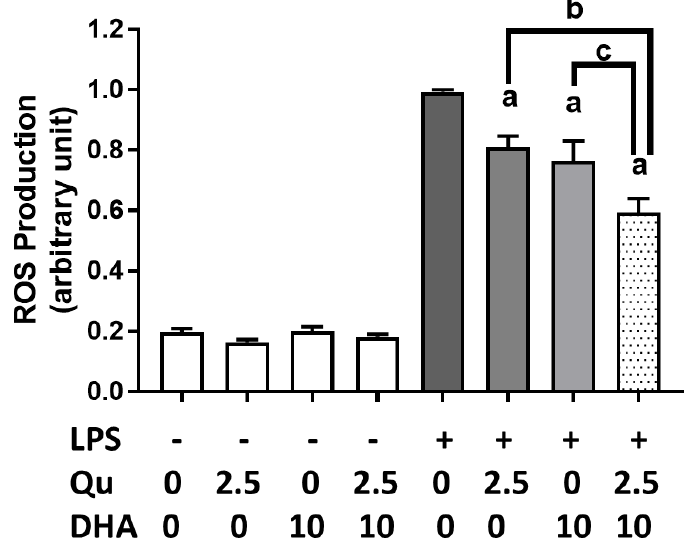
Figure 2. Effects of DHA and/or quercetin on LPS-induced reactive oxygen species (ROS) production in microglial cells. ROS was detected using CM-H 2 DCFDA (DCF), as described in text. “a” represents significant differences ( p < 0.01) between control versus treatments. “b” and “c” represent significant differences ( p < 0.05) between the indicated pairs.